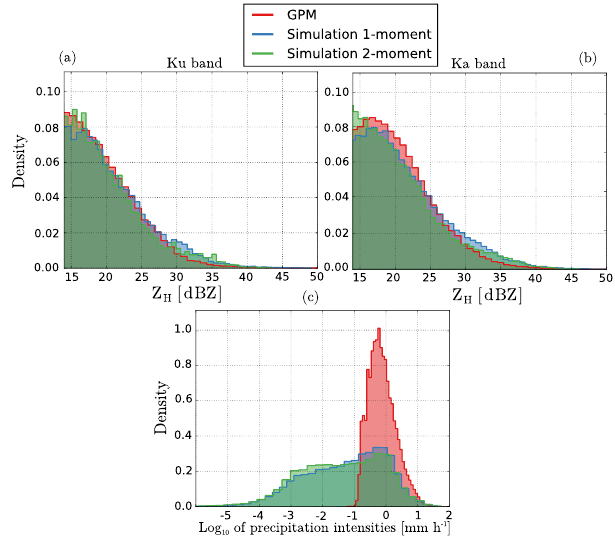
Figure 20. Observed (red) and simulated (blue = one-moment, green = two-moment) reflectivities at Ku band (a) and Ka band (b) , as well as the precipitation intensities (in log-scale) at the ground (c) estimated by GPM and simulated by